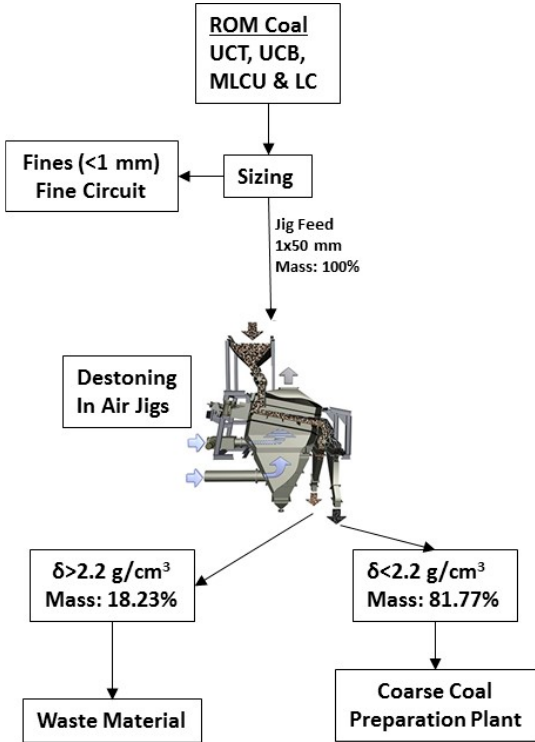
Figure 4. Flowsheet of the destoning circuit and the approximate mass balance.